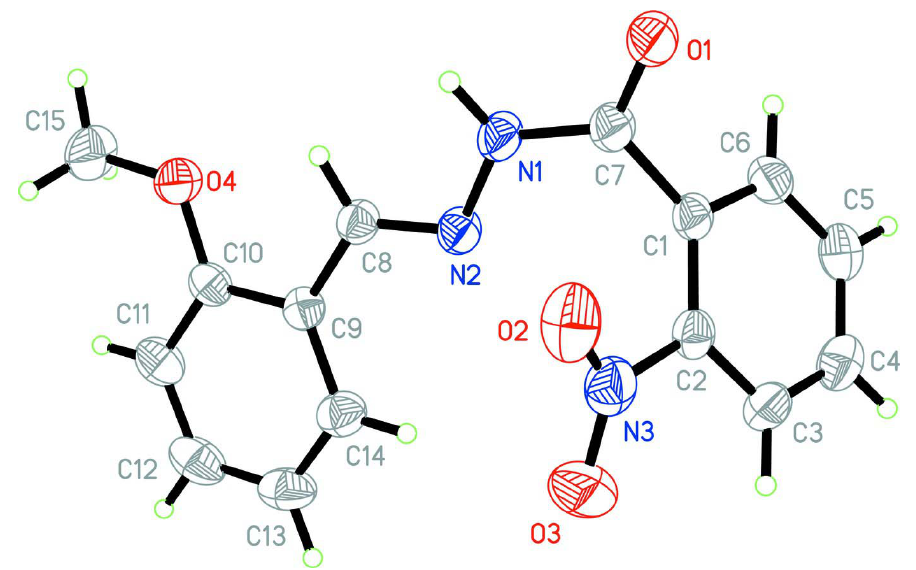
Figure 1 The molecular structure of (I), showing 30% probability displacement ellipsoids and the atom-numbering